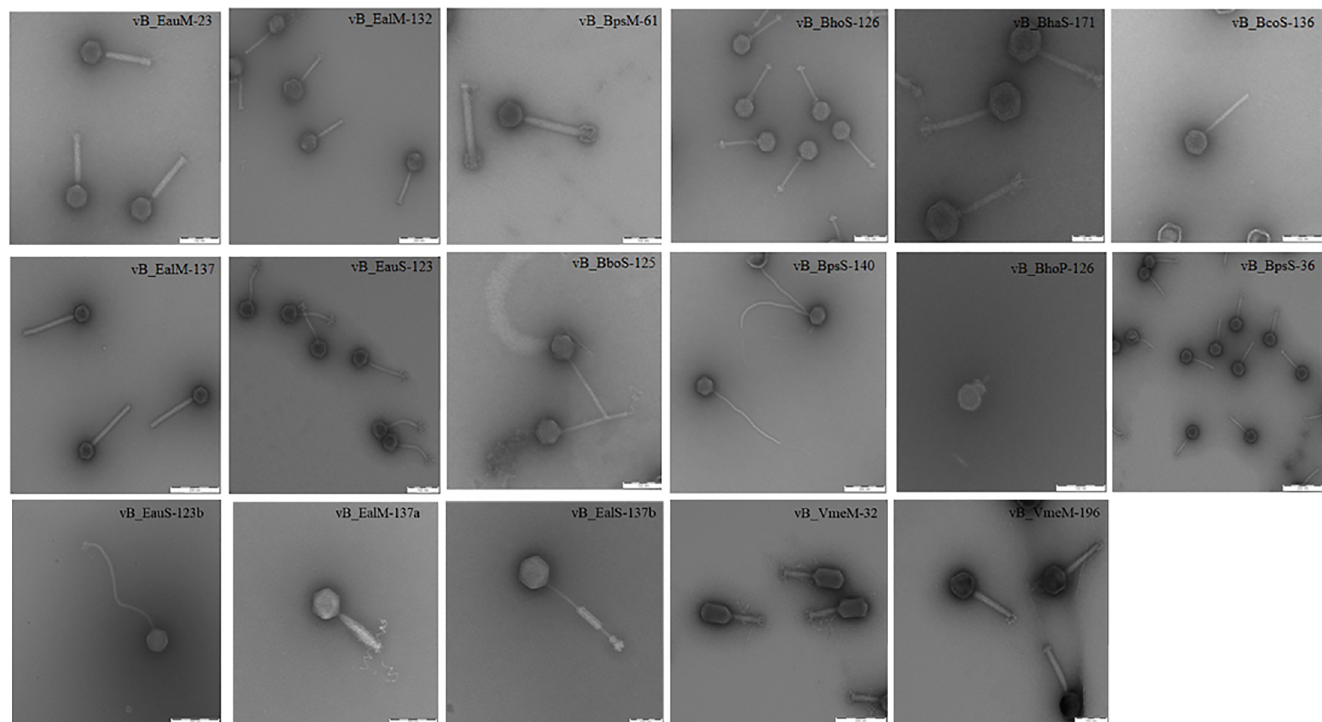
Fig 1. Transmission electron micrographs. Micrographs of bacteriophages from Lake Elmenteita showing different morphotypes. CsCl-purified bacteriophage preparations were negatively stained with 2% (w/v) aqueous uranyl acetate (pH 5.0). Samples were examined in a TEM 910 transmission electron microscope (Carl Zeiss, Oberkochen) at an acceleration voltage of 80 kV.